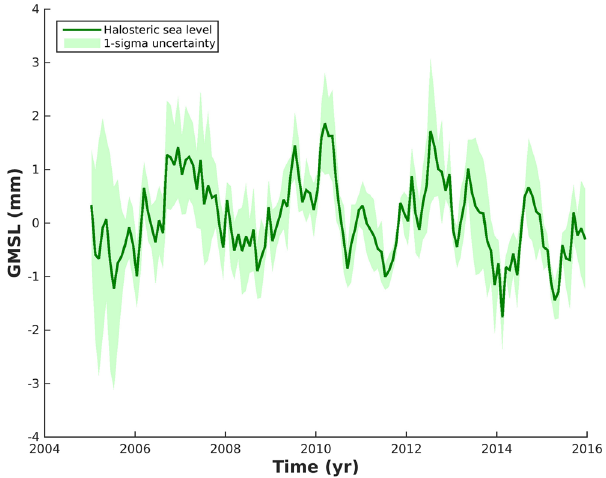
Figure 2. Salinity contribution to sea level. Temporal variability in the halosteric (green curve) sea level estimated from Argo data (0–2000 m). Seasonal signals have been removed from all curves. Shading denotes 1- σ uncertainty of the respective